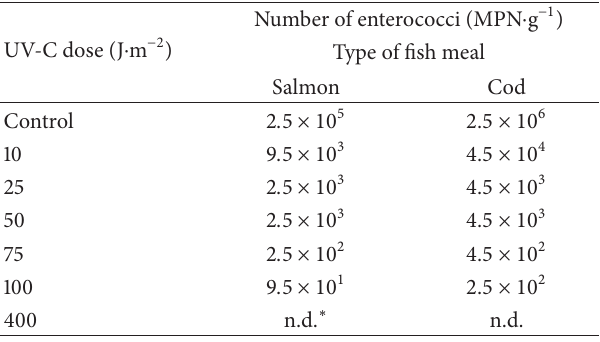
Table 4: Changes in the number of Enterococcus spp. depending on the surface density of the UV-C radiation